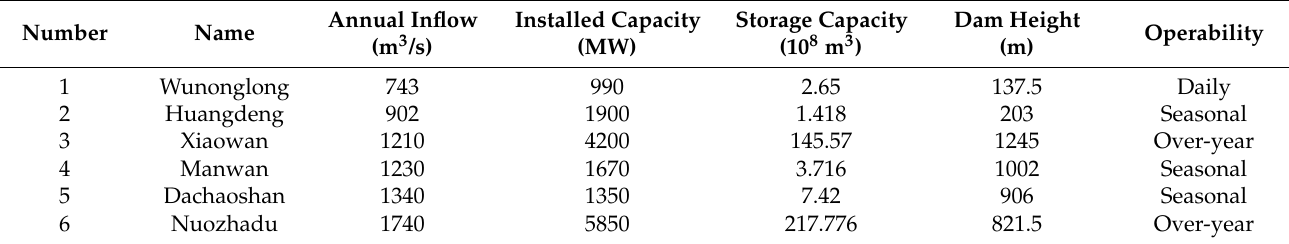
Table 2. The basic parameters of cascaded hydropower reservoirs.